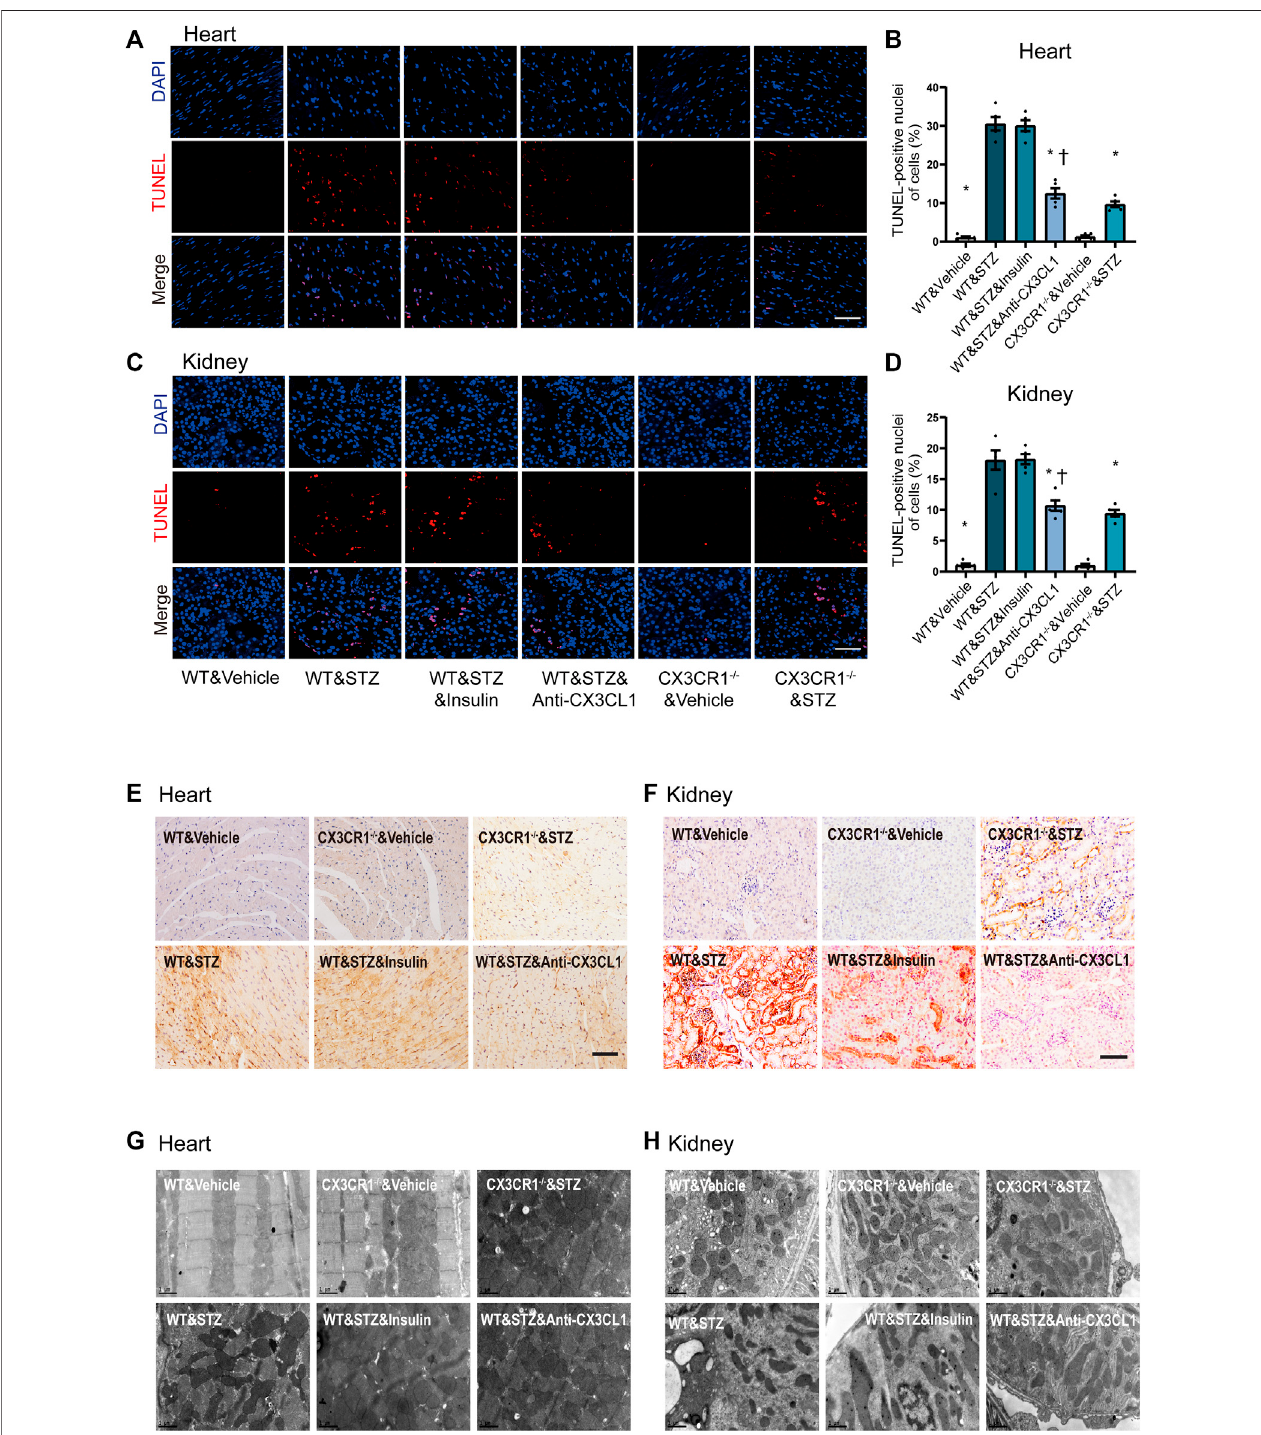
FIGURE5| InhibitionofCX3CL1/CX3CR1attenuatedapoptosisinmicewithSTZ-induceddiabetes. (A) RepresentativeimagesofTUNELstaininginheartsections at 6 weeks after STZ-injection. (B) Percentage ofTUNEL-positive nucleiin heart tissue. (C) Representative images ofTUNEL staininginkidney sections at 6 weeks after STZ-injection. (D) PercentageofTUNEL-positivenucleiinkidneytissue. (E) Baximmunostaining(brownstaining)inhearttissue. (F) Baximmunostaininginkidneytissue. (G) Representative electronic micrographs of the heart featuring sarcomeres and mitochondria. (H) Representative electronic micrographs of the kidney featuring tubular mitochondria. For panel (B) and (D) , * p < 0.05 vs . WT&STZ mice; † p < 0.05 vs . WT&STZ&Insulin mice, n = 5 in each group. Scale bar = 100 μ m in panel (A) and (C) , Scale bar = 1 μ m in panel (G) and (H) . Experiments presented in panels (B) and (D) were analyzed using one-way ANOVA followed by Bonferroni ’ s post hoc test.